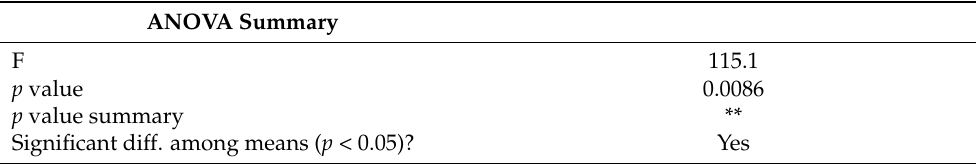
Table 2. One-way ANOVA findings for synthesized nanocomposites (comparison of inhibition zone between three